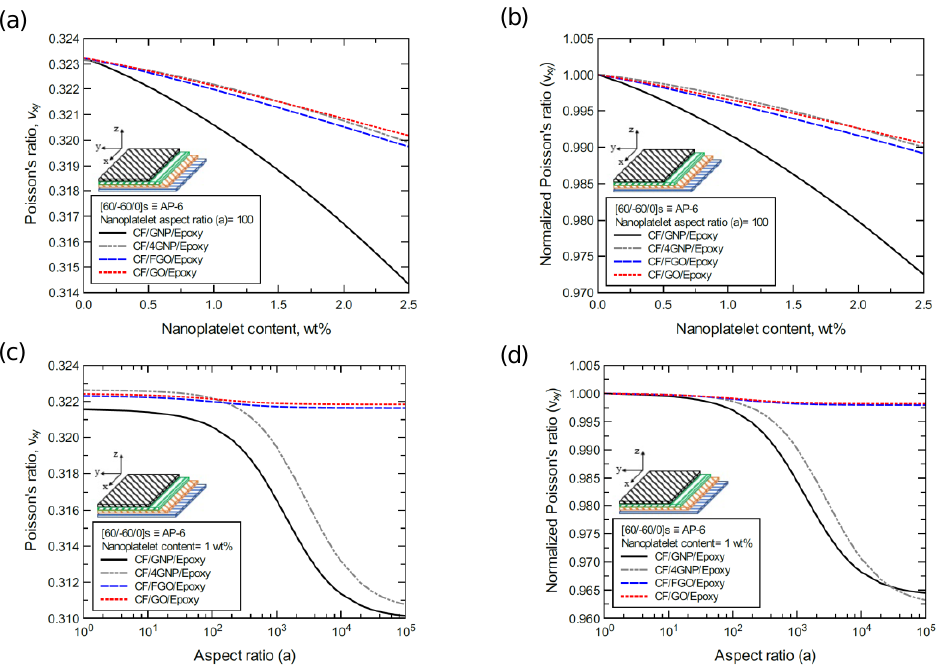
Figure 26. Comparison of the predicted in- plane Poisson’s ratio (ν xy ) for a [60/-60/0]s (AP-6)-laminated composite plate based on the nanoplatelet type, content, and aspect ratio; ( a ) predicted ν xy for various nanoplatelet contents at 100 aspect ratio, and the normalized response is shown in (b ); ( c ) predicted ν xy for various aspect ratio values at 1.0 wt% nanoplatelet content, and the normalized response is shown in ( d ). The volume fraction of CF is 56%.